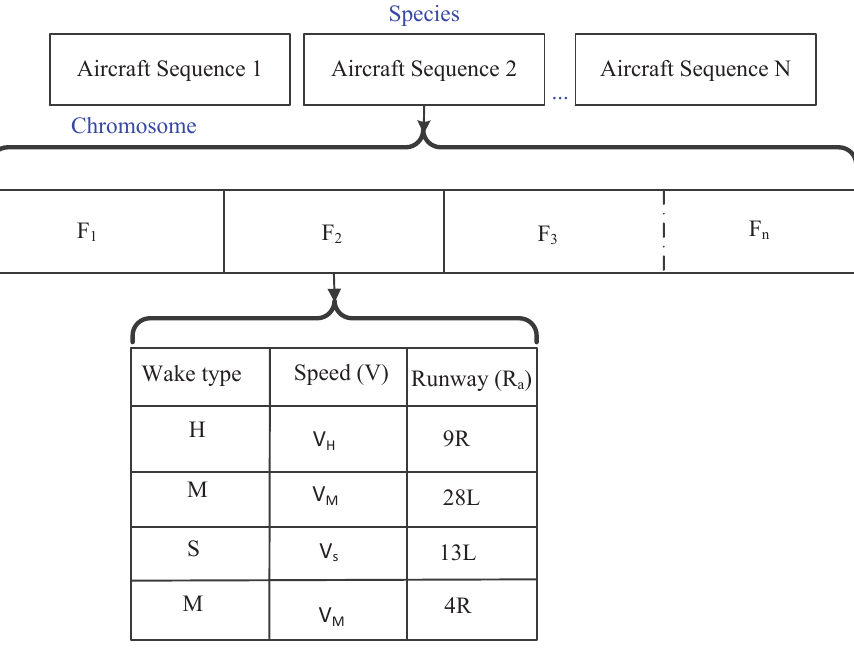
Figure 3. Chromosome (aircraft